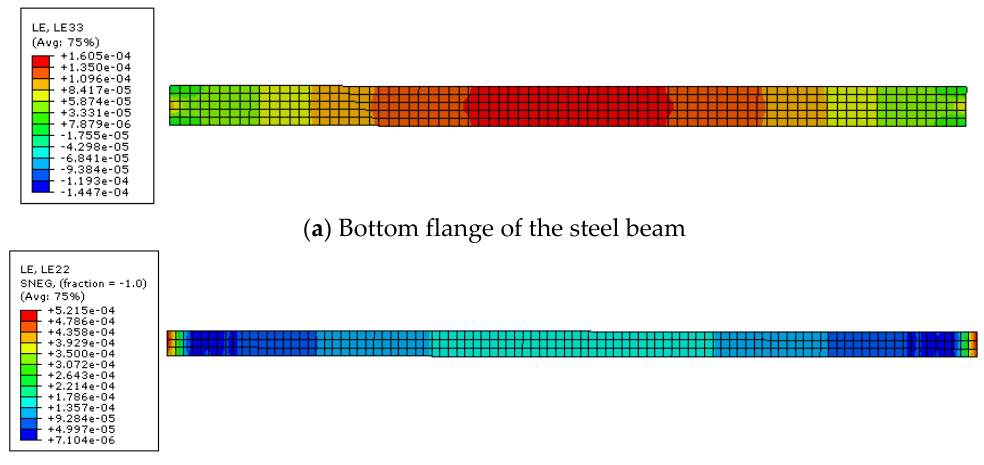
Figure 5. Strain distribution ata temperature of 20 °C.